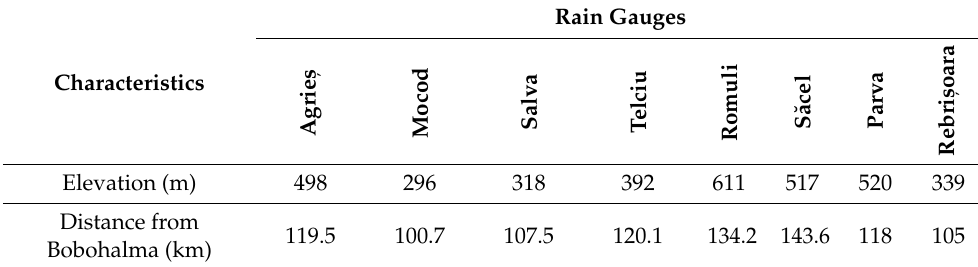
Table 2. Rain gauge